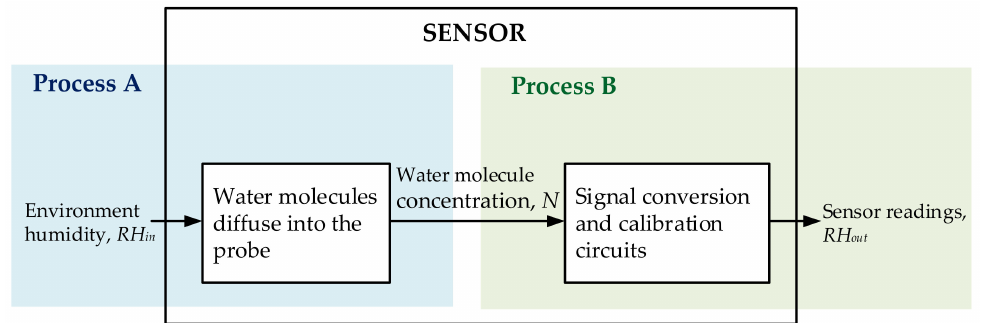
Figure 2. Decomposition of humidity-sensing process.